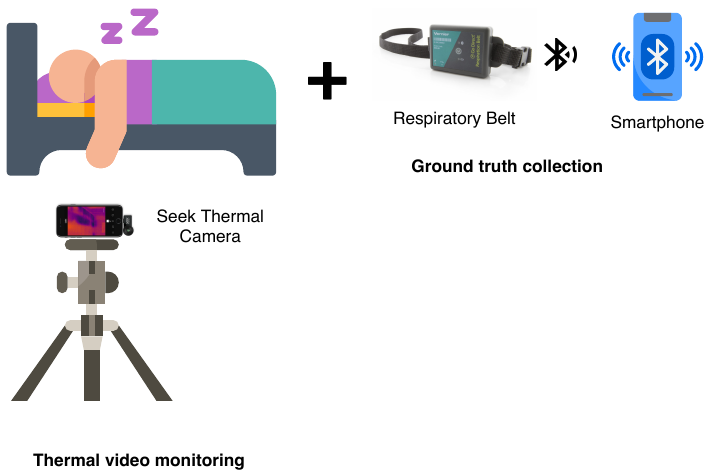
Figure 6. Data collection setup.